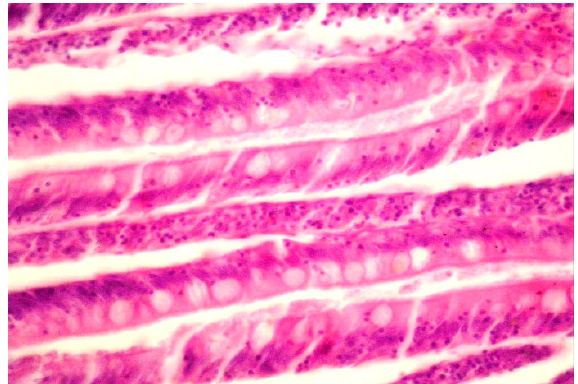
Fig. 2. Vacuolization of goblet cells of villi of the epithelial lining of carp intestine in Experiment 3. H&E. x